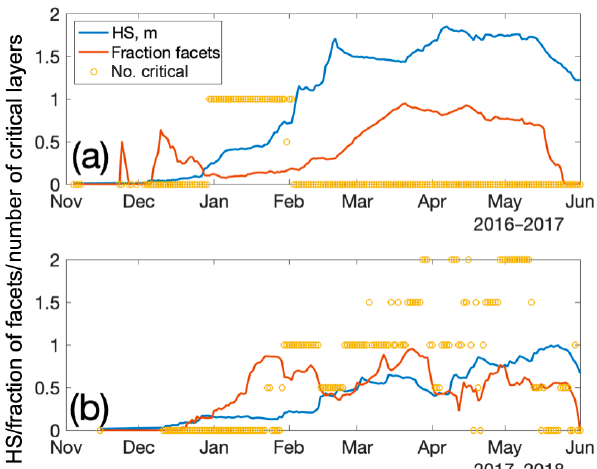
Figure 10. Stratigraphy summary of the (13 × 13) 25km pixels con- taining AKAH stations for 2017 (a) and 2018 (b) . Plotted are the median values of the following: height of snow (HS), fraction of the snowpack containing facets, and number of critical